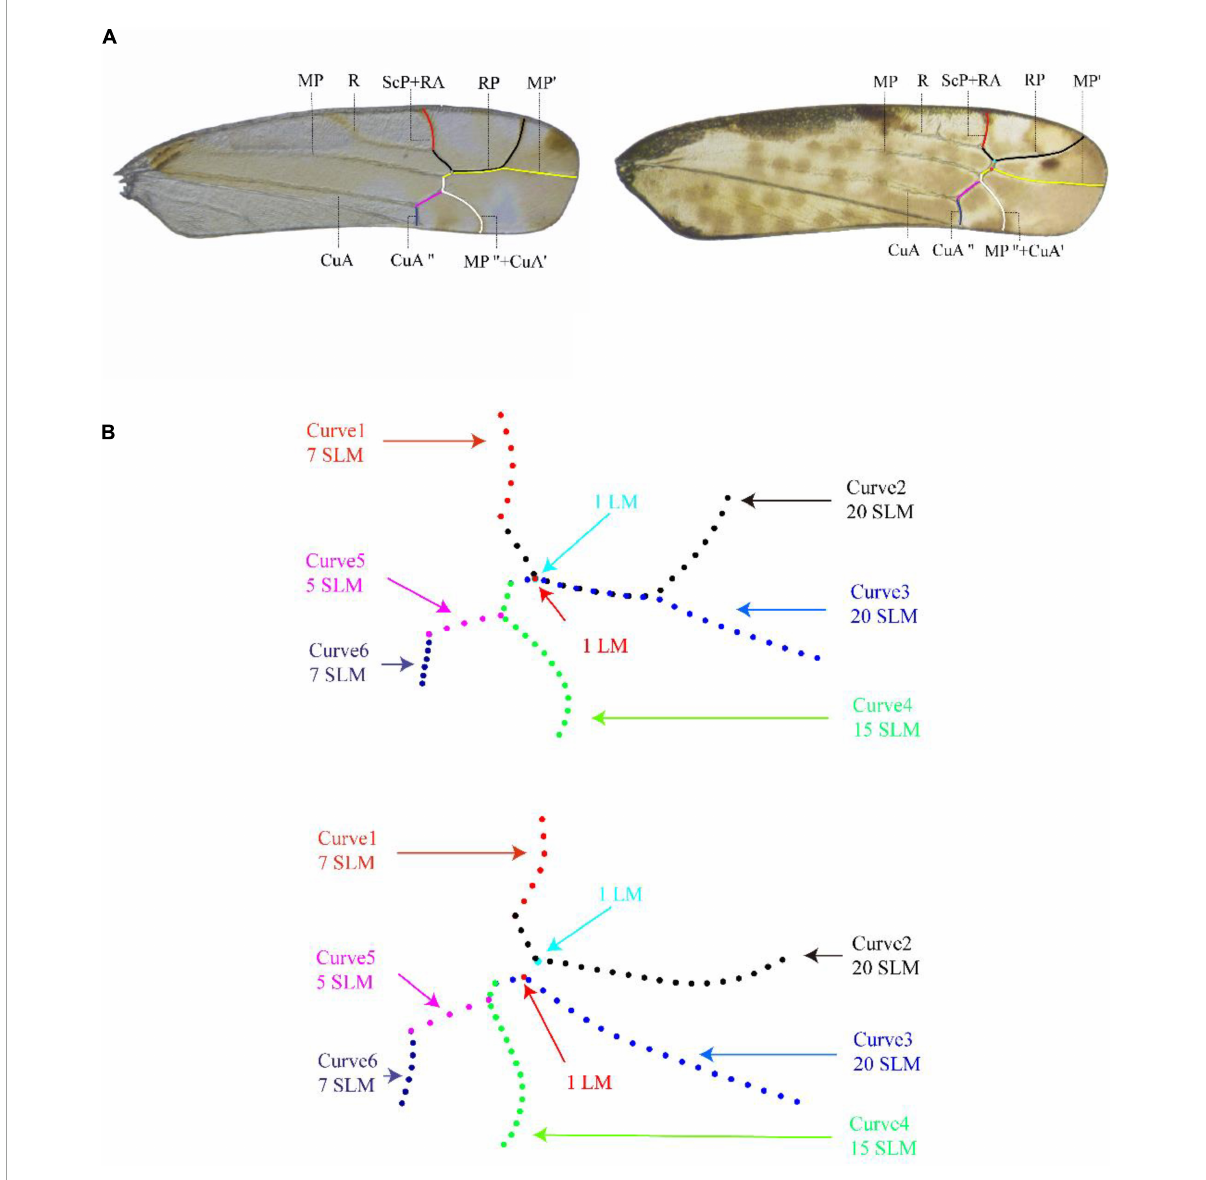
FIGURE1 Description of the curves on the apical area of forewing of Typhlocybinae used in the geometric morphometric analysis [right forewing of Aguriahana triangularis Matsumura, 1932 (left picture) and Parathailocyba orla Dworakowska, 1977 (right picture)]. (A) The apical area of forewing venation described by the six curves in red, black, yellow, white, pink, and mazarine blue are ScP + RA, RP, MP (cid:48) , MP (cid:48)(cid:48) + CuA (cid:48) , CuA (cid:48) , and CuA (cid:48)(cid:48) , respectively (main venation of wings). (B) Curves 1 and 6 are 7 equally spaced semi-landmarks, curves 2, and 3 are 20 equally spaced semi-landmarks, curve 4 are 15 equally spaced semi-landmarks, and curve 5 are 5 equally spaced semi-landmarks.